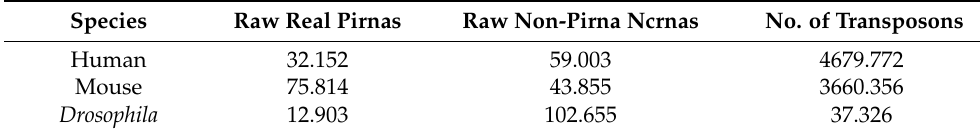
Table 2. The datasets from three model organisms used for training the ensemble method. Species Raw Real